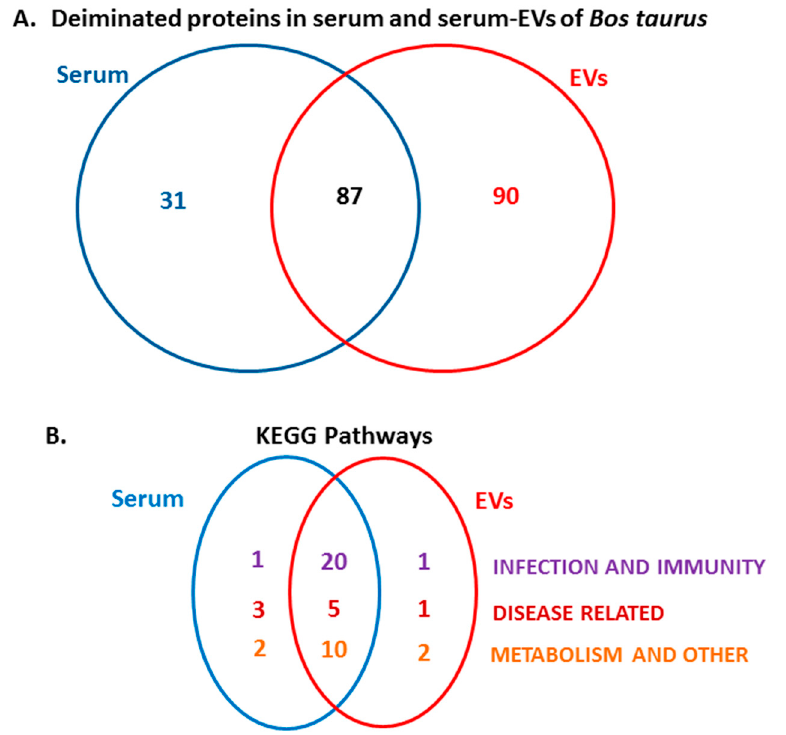
Figure 3. Deiminated proteins identified in bovine serum and serum-EVs. ( A ) Species specific hits identified for deiminated proteins in bovine serum (Table 1) and serum-EVs (Table 2) respectively, as well as number of overlapping hits are presented. ( B ) KEGG (Kyoto Encyclopedia of Genes and Genomes) pathways identified to be enriched in deiminated proteins in bovine serum and serum-EVs respectively, as well as number of overlapping KEGG pathways, are presented. For specific KEGG pathways presented in the Venn diagram, see the protein–protein interaction networks in Figures 4– 8.